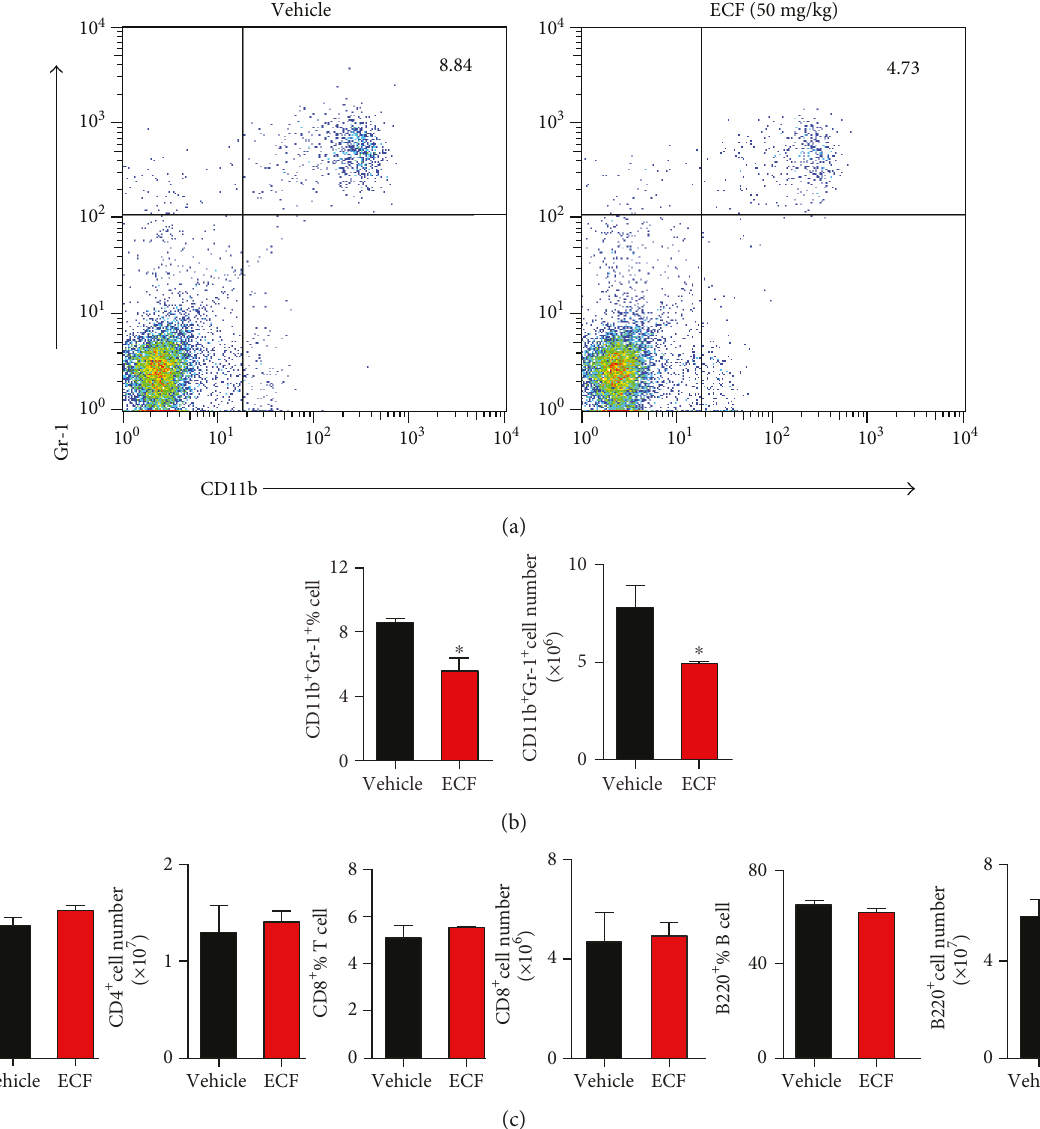
Figure 4: ECF treatment signi fi cantly reduces accumulation of neutrophils. Splenocytes from CIA mice were harvested and blocked with rat- anti-mouse CD16/CD32 and fl uorescently labeled by incubation for 15min at 4 ° C with the respective antibody. Samples were measured on fl ow cytometer and analyzed by FlowJo software. Results presented are mean ± s.e.m., n = 4 . ∗ P < 0 05 , ∗∗ P < 0 01 versus vehicle